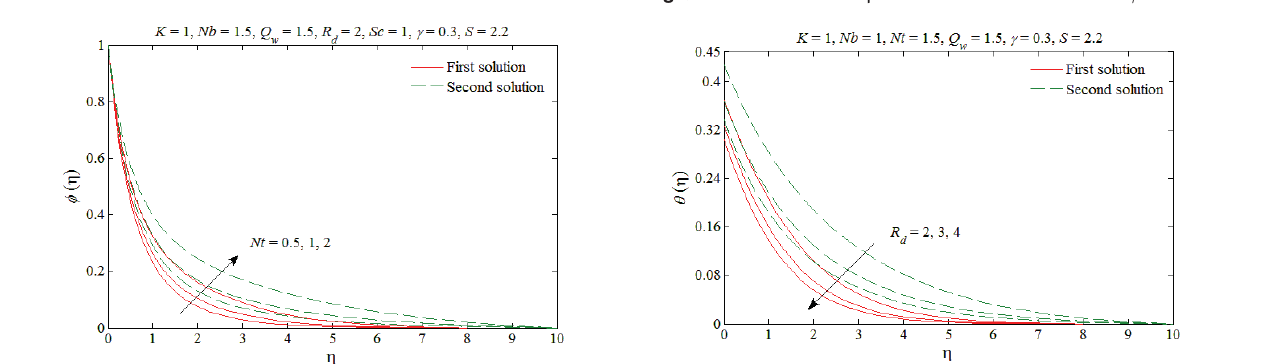
Fig. 6: The temperature profiles for different values of Nt .